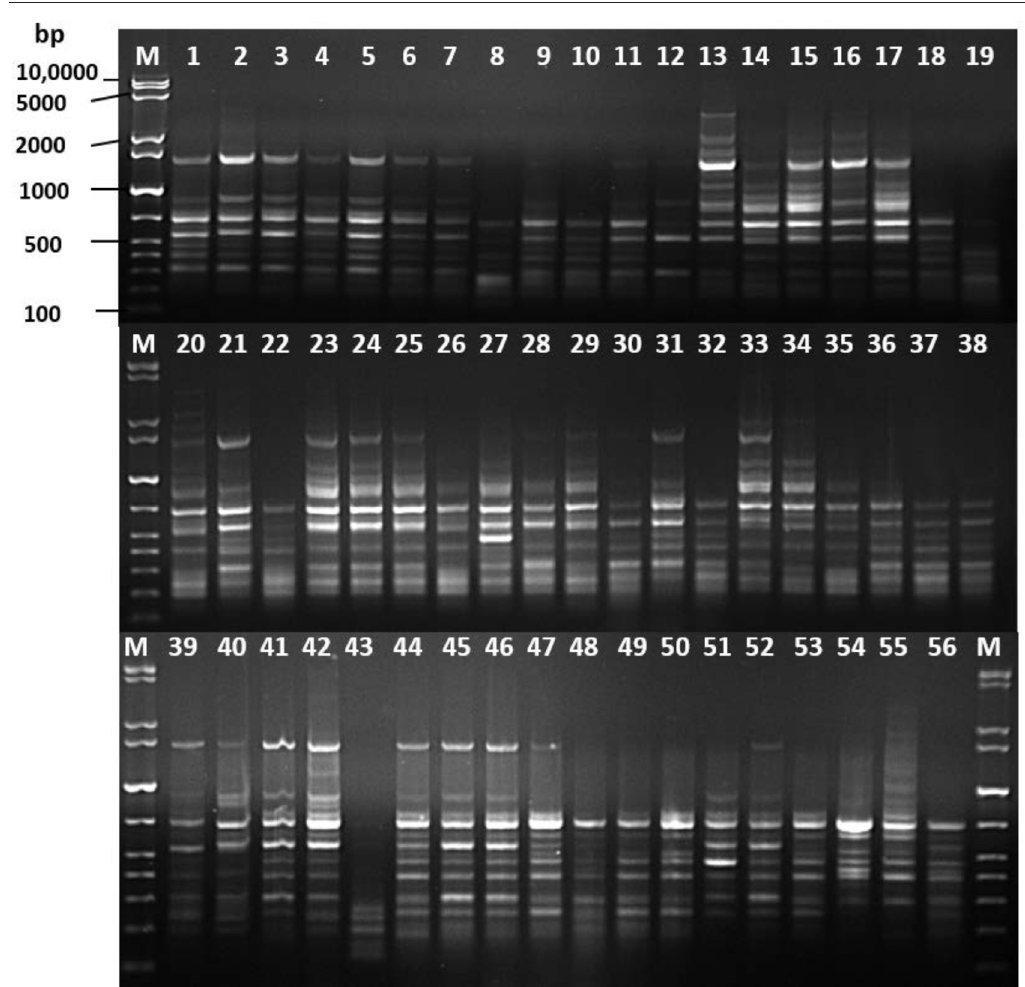
Fig. 2. DNA fingerprint analysis of the 56 carbapenem-resistant Acinetobacter baumannii by ERIC-PCR. M: GelPilot 1 Kb Plus